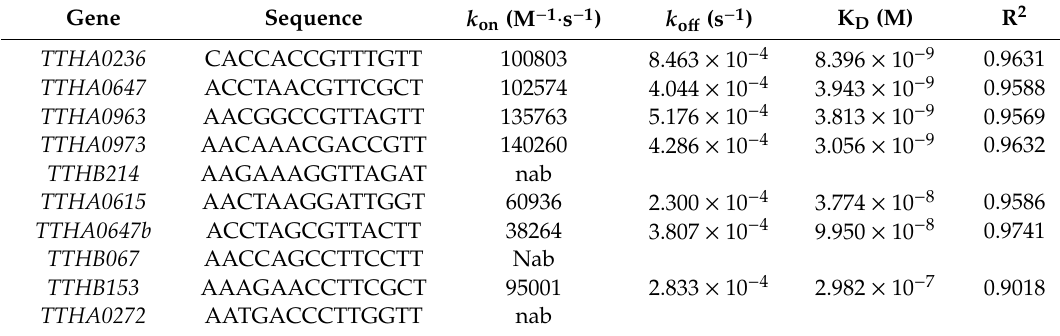
Table 3. TTHA0973-promoter binding